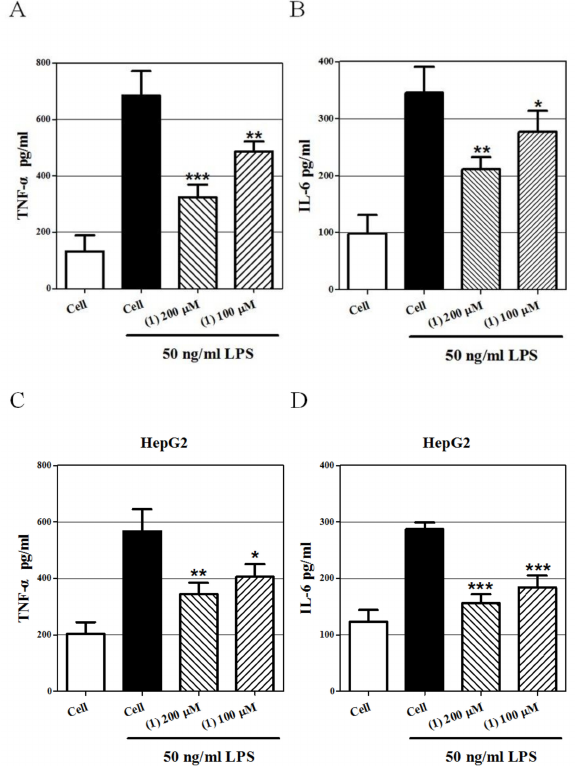
Figure 6. Effect of castanol B (1) on cytokines secretionon lipopolysaccharide(LPS)-induced hepatoma cells. TNF- α ( A ) and IL-6 ( B ) expression in SMMC-7721 cells was inhibited by castanol B (1) . TNF- α ( C ) and IL-6 ( D ) expression in HepG2 cells was inhibited by castanol B (1) . (* denotes p < 0.05; ** denotes p < 0.01; *** denotes p < 0.001, vs. LPS-induced hepatoma